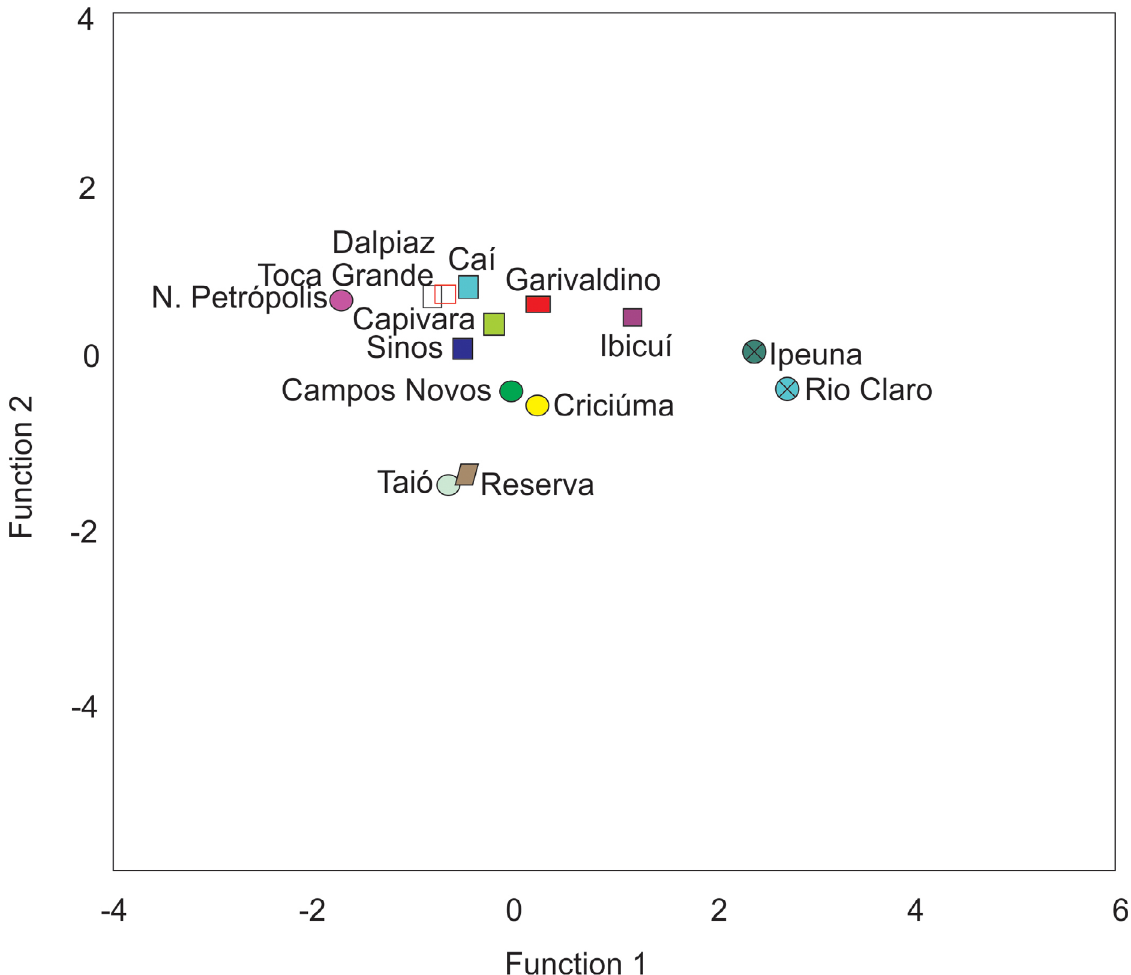
Figure 6: Graph representing the two canonical functions. Crossed circles: São Paulo state, parallelogram: Paraná state, circles: Santa Catarina state, and squares: Rio Grande do Sul state. The first function explains 53,4% of total variance and the second function explains